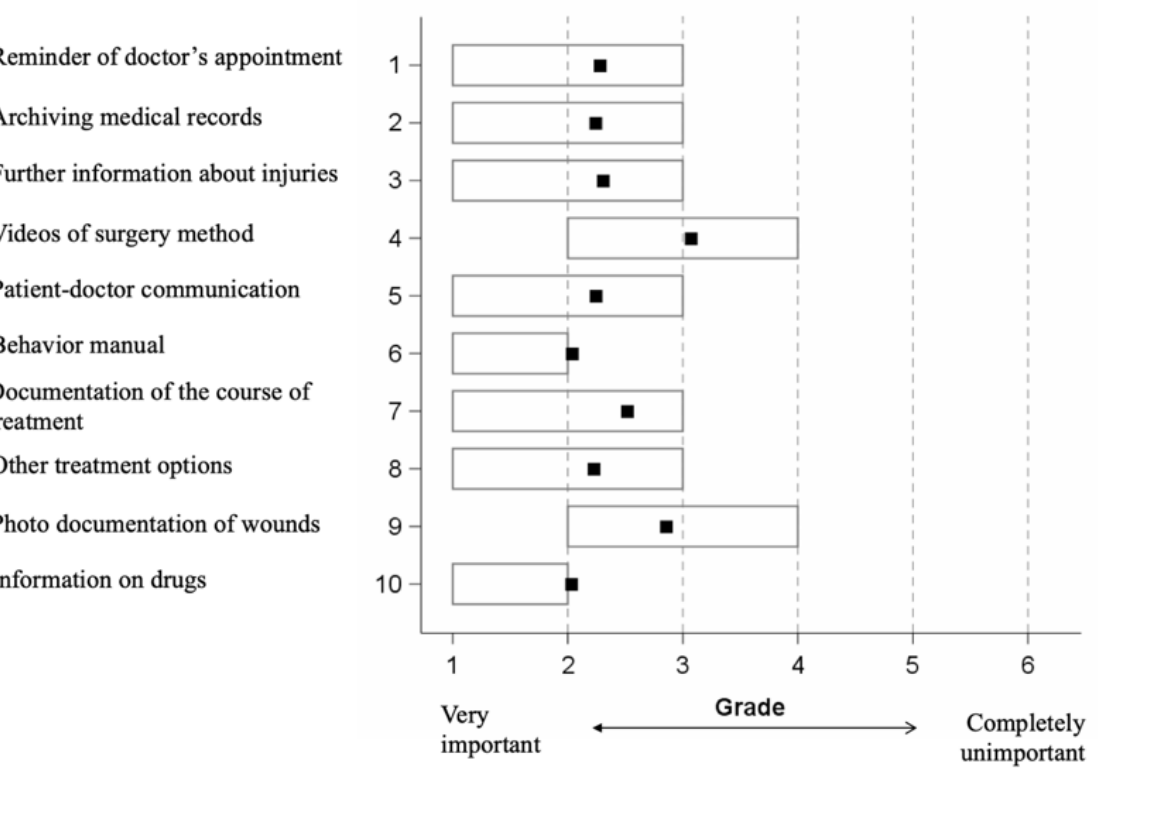
Figure 2. Evaluation of the features of a fictitious app by the patients in trauma surgical care (N=1055). The evaluation was based on a 6-point